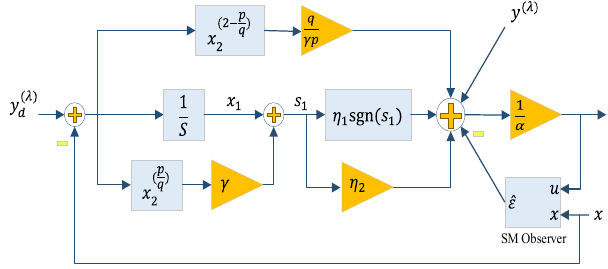
Figure 5. Illustration of the MINTSMC controller with an SM observer.